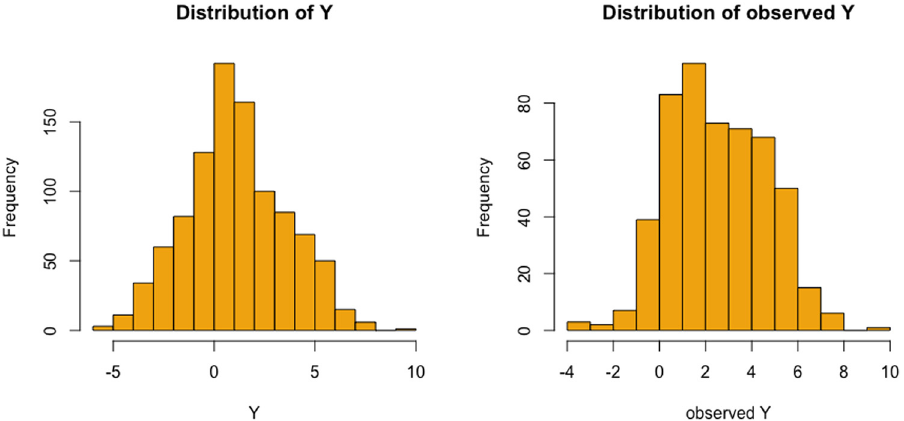
Figure A2: The observed distribution of X 3 causes the distribution of observed Y to shift to the right, which results in an upward bias.